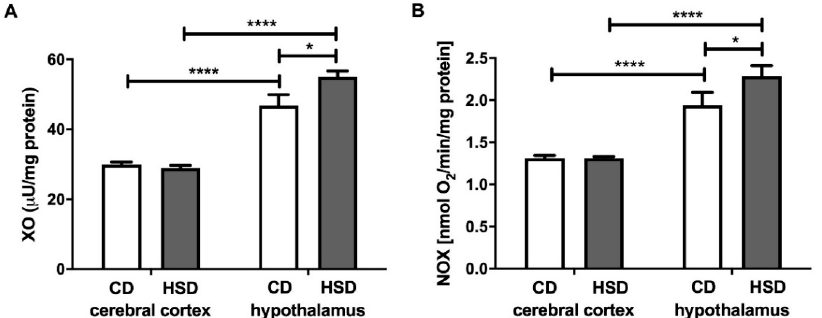
Figure 1. Prooxidant brain enzymes (xanthine oxidase ( A ) and NADPH oxidase ( B )) in the